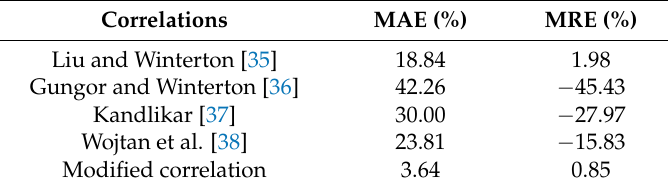
Table 7. Prediction accuracy of the heat transfer